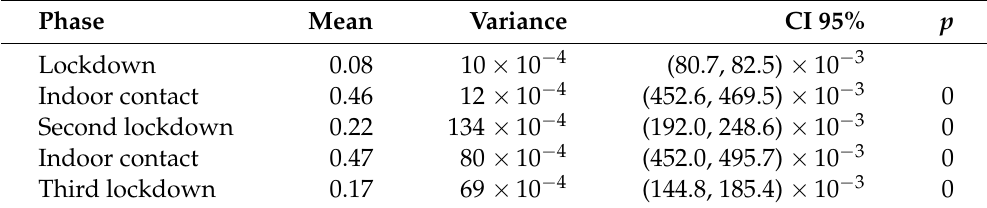
Table 6. Histogram for the mean values of β E at the different stages of lockdown in the